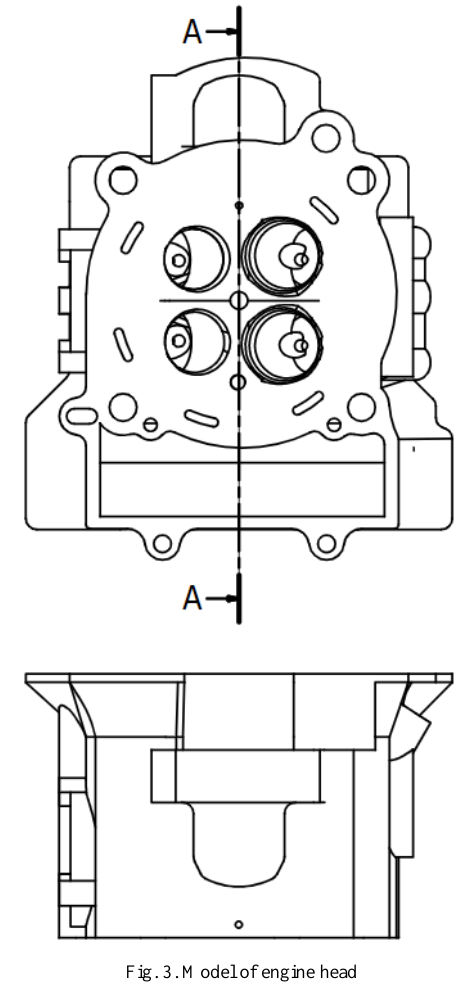
Fig. 3. Model of engine head